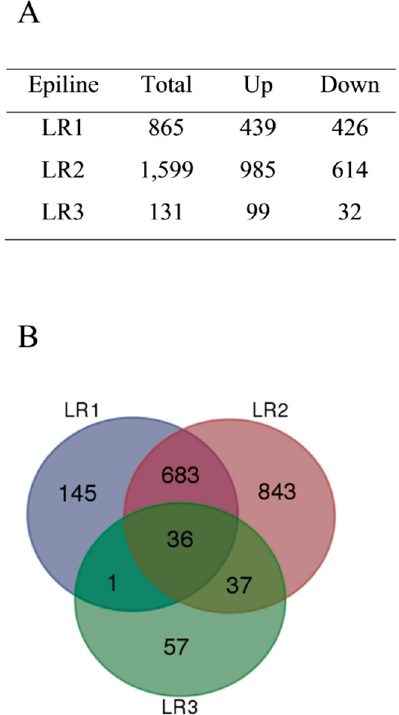
Figure 1. Total, common and specific differentially expressed genes (DEGs) in epiline LR1, LR2, and LR3 transcriptomes. Comparative transcriptome analysis of total DEGs ( p < 0.01; false discovery rate (FDR) ( q ) < 0.05, | log 2 fc | > 0.6). ( A ) Number of total up ‐ and down ‐ regulated DEGs; ( B ) Venn diagram